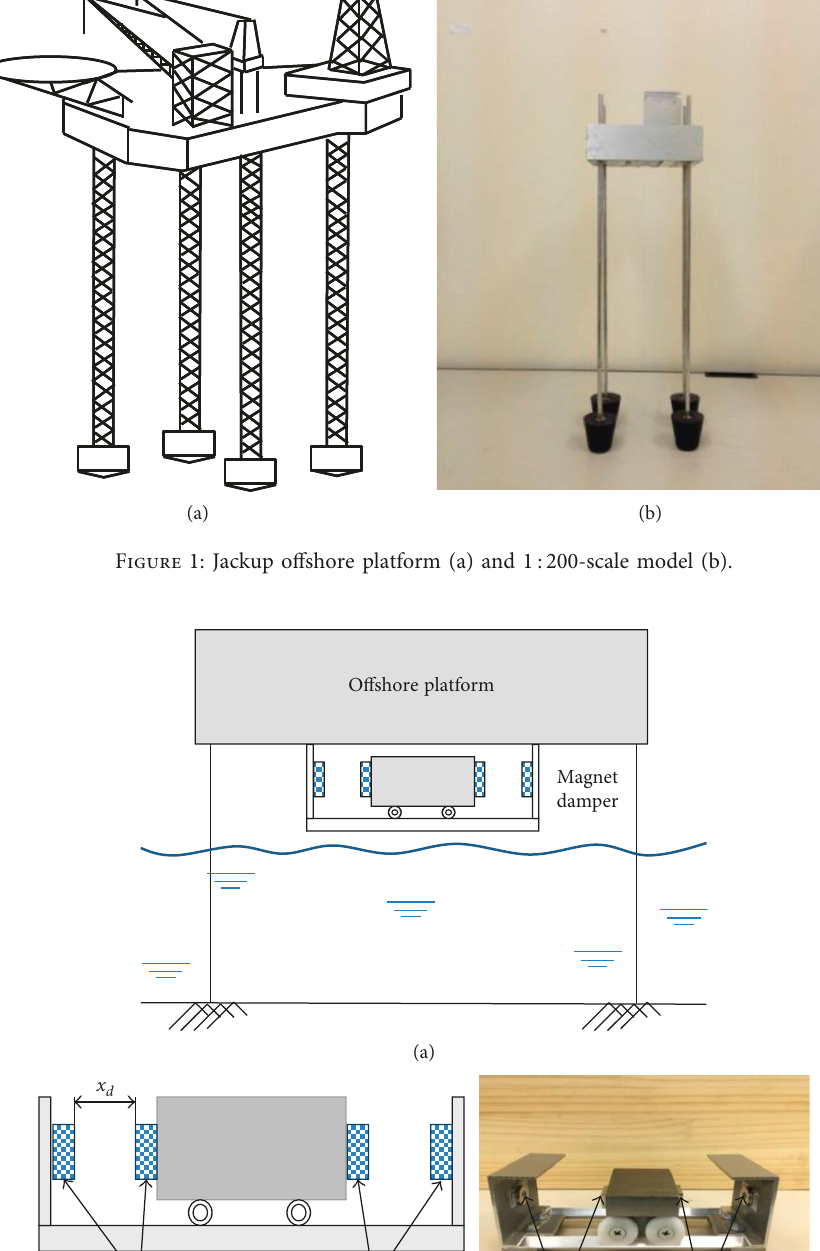
magnets generate a time-varying magnetic force which is inversely proportional to the gap x